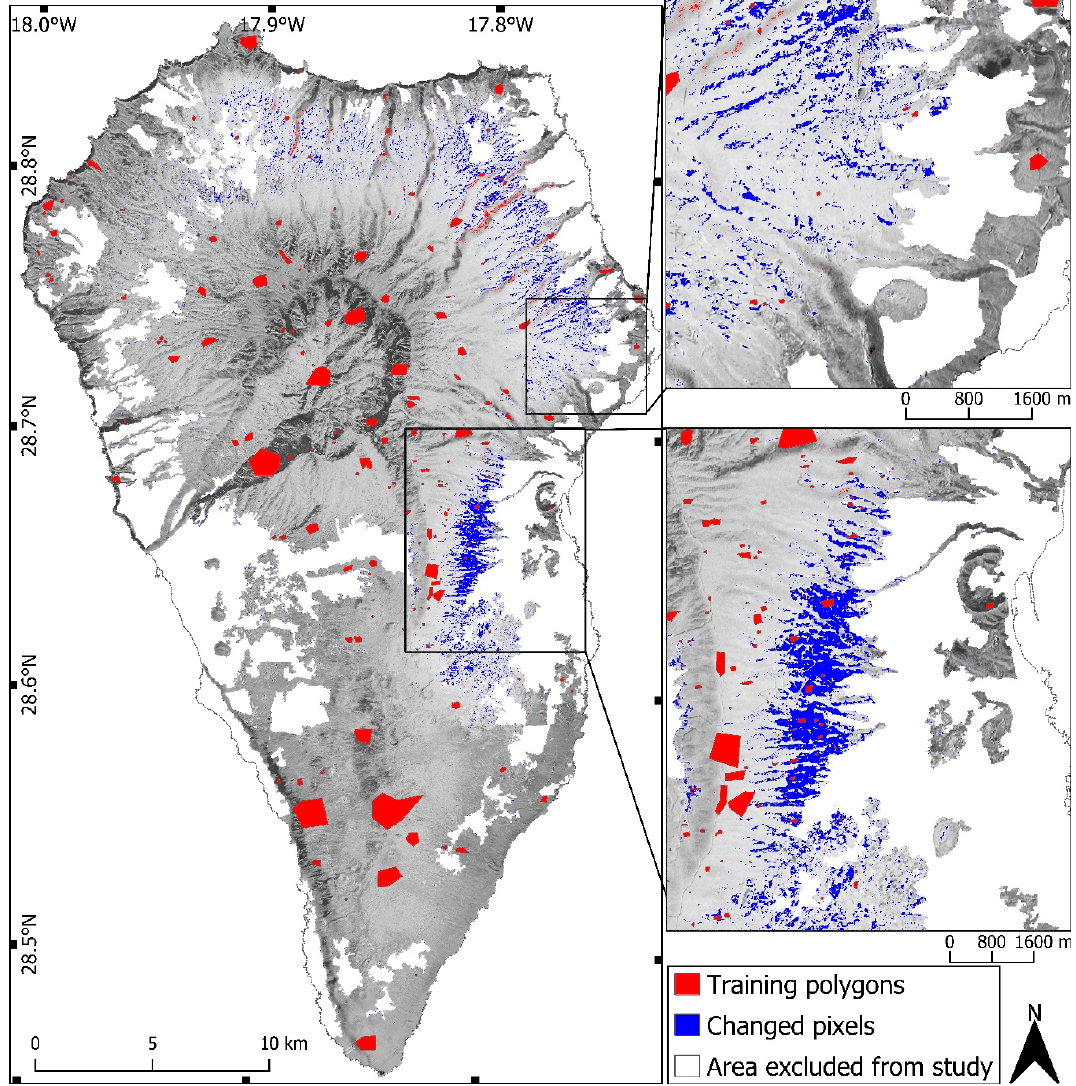
Figure 3. Changed pixels (proxy for leaf on/leaf off) between July 2018 and February 2019 in the Sentinel-2 image obtained from the image regression and image differentiation, grayscale raster composite, red-NIR, red, green, each band with 1/3 saturation. Blue colour highlights changed pixels between those dates. Training polygons (red) are the training samples used to discriminate between changed and unchanged pixels. Settlements and other intensive human land-uses were cropped out (shown in white, excluded from study).